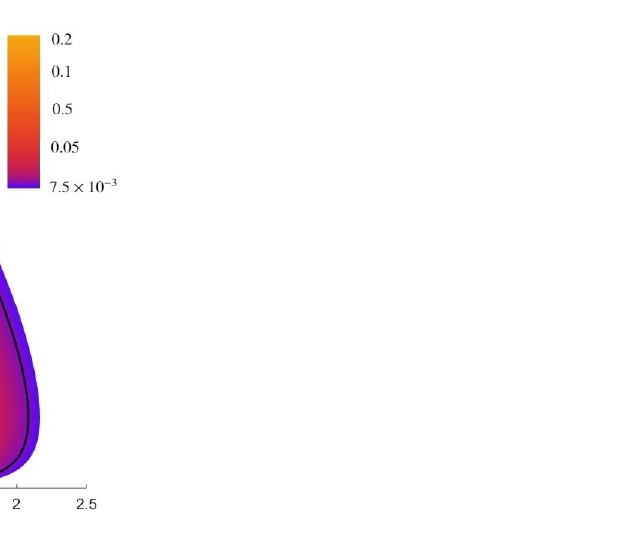
Figure 4. The radius–height contour plots of dimensionless toroidal velocity, v φ = v φ / v φ 0 . Axis labels given by Z = z and R = r . r 0 L